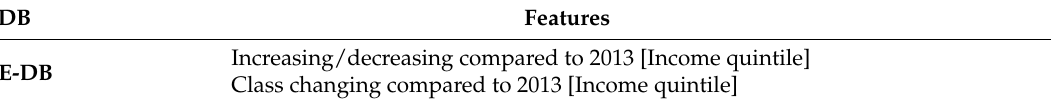
Table 7. Features of longitudinal data-based experiment